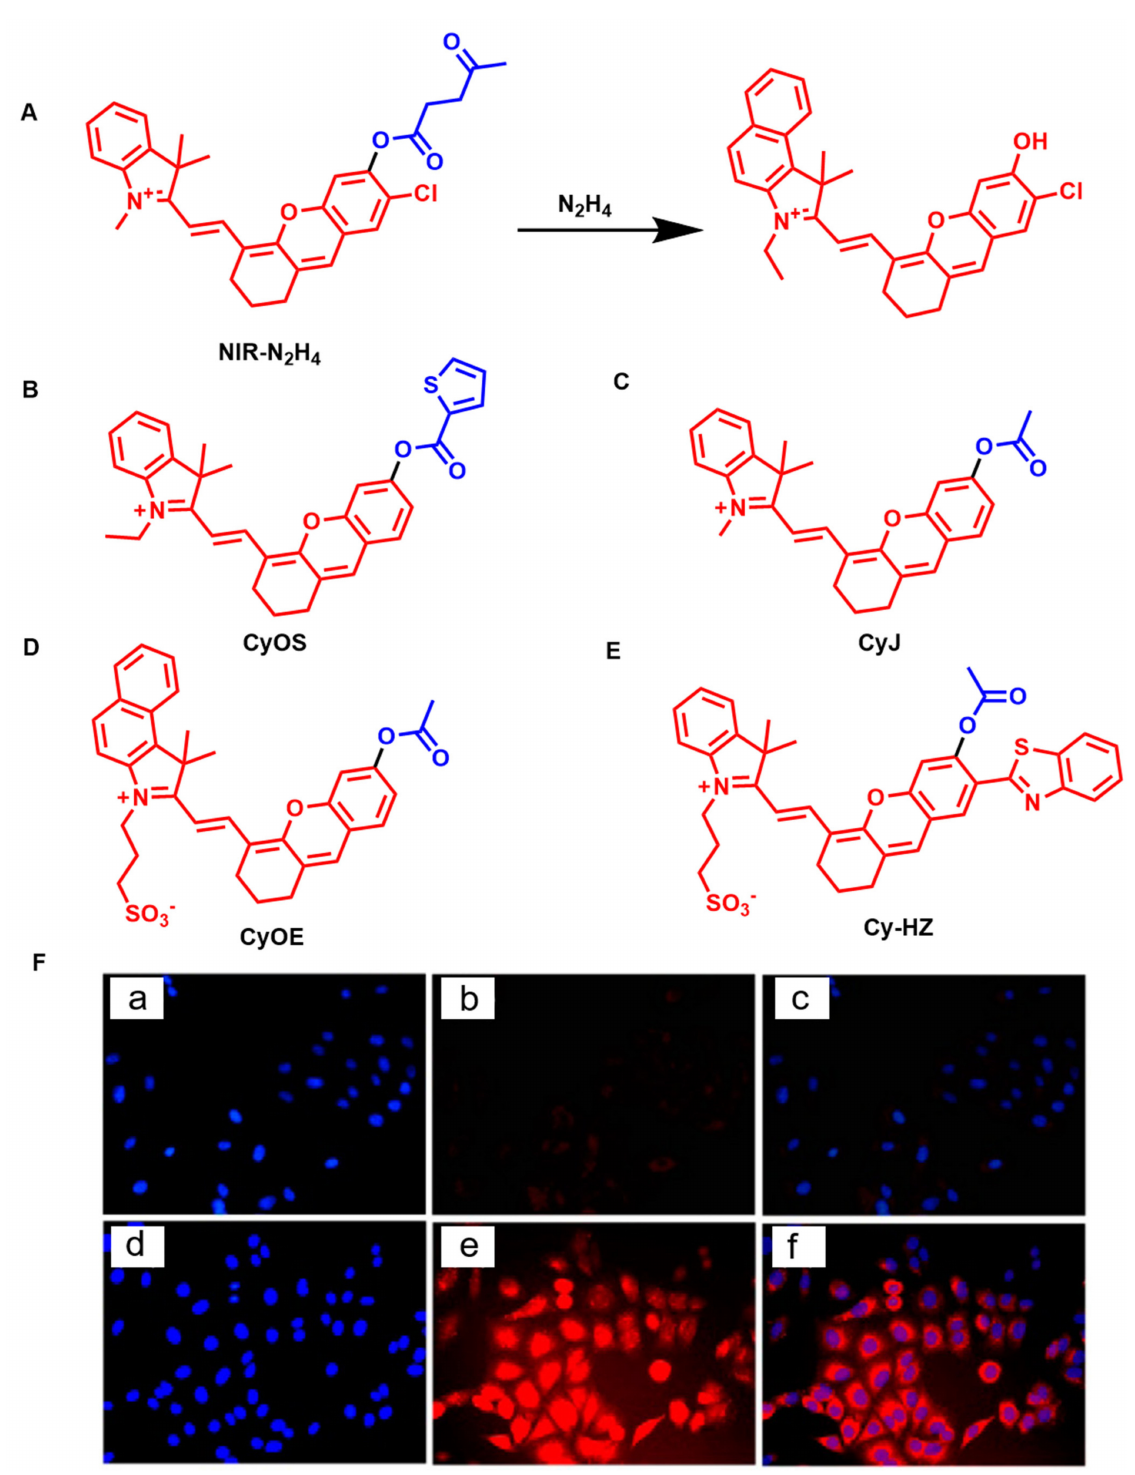
Figure 16. The response mechanisms and chemical structures ( A – E ) of fluorescent probes for N 2 H 4 . ( F ) Confocal microscope images of CyJ in HeLa cells. ( a , d ) Fluorescence images from DAPI; ( b , e ) Flu- orescence images from CyJ; and ( c , f ) Merge. Reproduced with permission from Ref. [91]. Copyright (2015) American Chemical